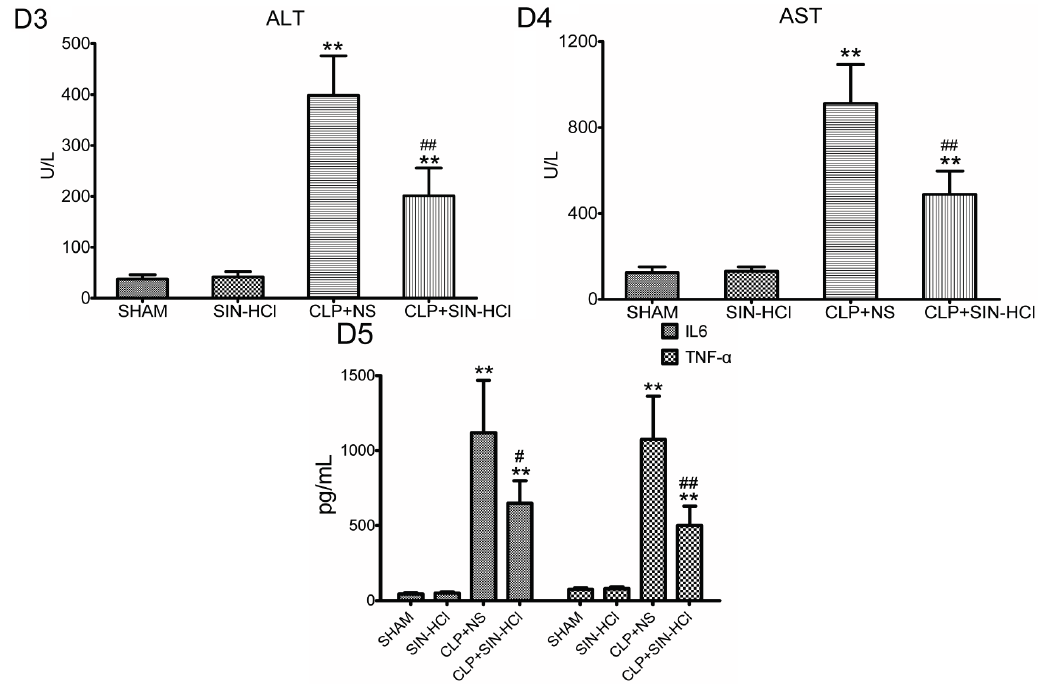
Figure 2. SIN-HCl protected a mouse model against polymicrobial sepsis and attenuated the multiple organ dysfunction and systemic inflammatory response. ( A ) SIN-HCl improved the survival rate of mice with CLP-induced sepsis. BALB/c mice were subjected to CLP surgery. SIN-HCl (100 mg/kg) was administered by hypodermic injection at 0 h ( A1 ) or 4 h ( A2 ) after CLP surgery. NS was used as the control. * p < 0.05 when compared with CLP + NS group. Data were pooled from three experiments, n = 10 per group in each experiment; ( B ) The lungs, liver, and kidneys were stained with HE. The organ damage induced by CLP was attenuated significantly in SIN-HCl-treated BALB/c mice, as evidenced by less inflammatory cell infiltration, reduced exudate blockage of capillary, and less substantial interstitial cellular degeneration and necrosis in the lungs, liver, and kidneys. Scale bar was equivalent to 50 μ m. Images were the selected representatives of kidney injury. ** p < 0.01 when compared with sham BALB/c mice, n ≥ 6; # p < 0.05